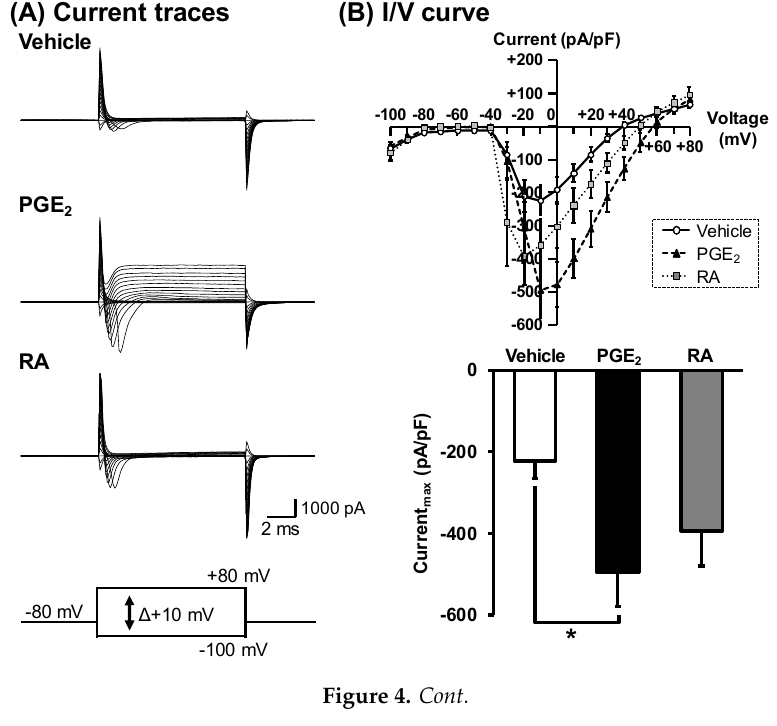
Figure 4. 246 M e 0 Vehicle RAPGE 2